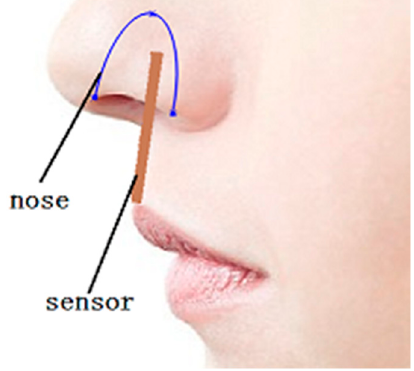
Figure 5. Schematic diagram of sensor position.